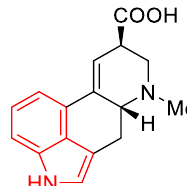
Figure 9. Indole scaffold (red) in the lysergic acid molecule.